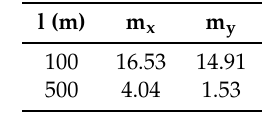
Table 1. γ − γ distribution parameters.